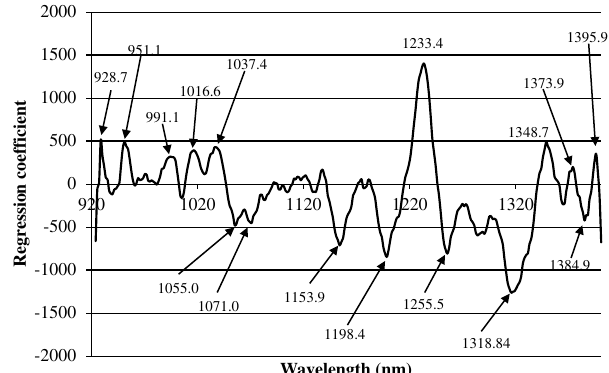
Fig. 7. Regression coe±cient PLS-DA model based on both transmittance and re°ectance of all orientation spectra omit- ting wavelengths related to hilum orientation.